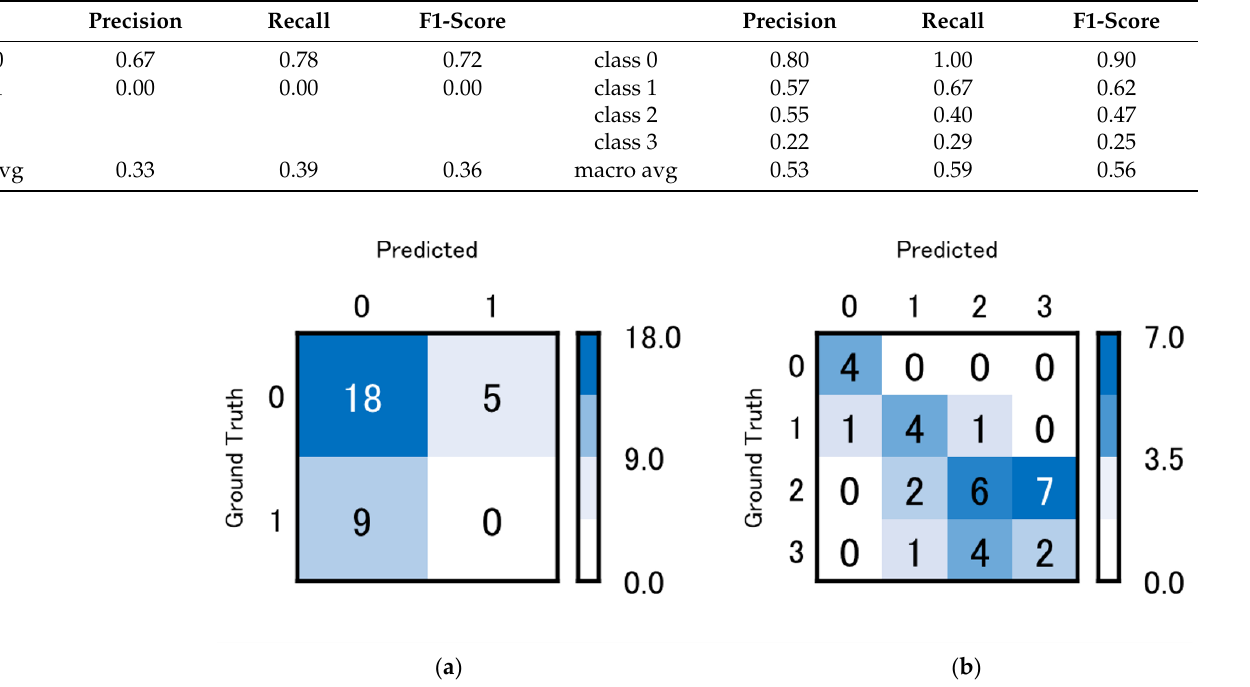
Table 4. Learning model’s performance.